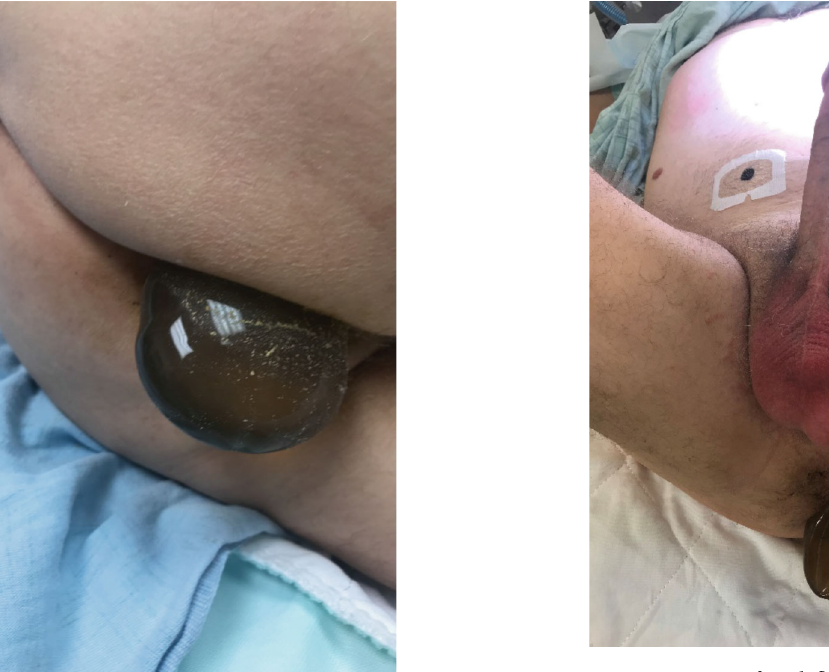
Figure 3: Protrusion of a de fl ated reservoir through the anus demonstrating maintained function of implant